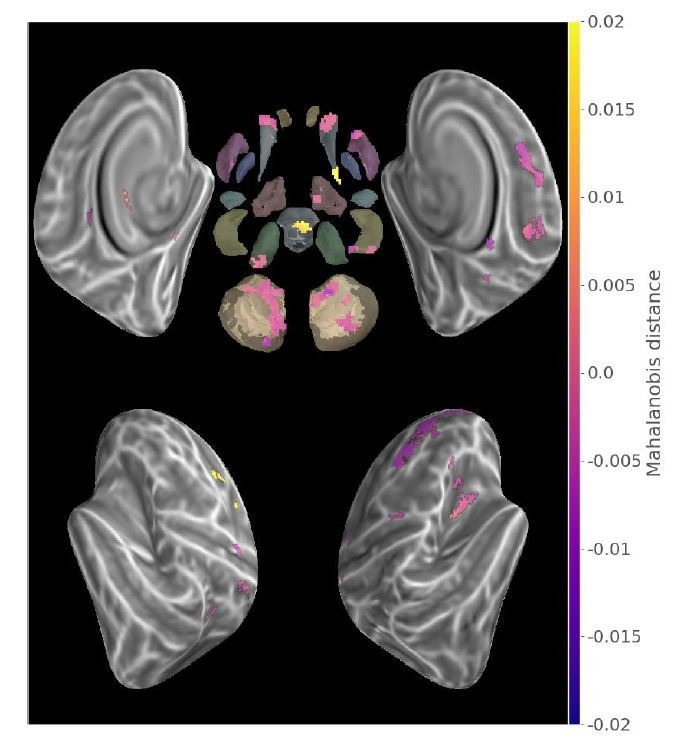
Contrast (run2-run1) between new sequences Mahalanobis distances (p<.05 Monte-Carlo TFCE corrected).